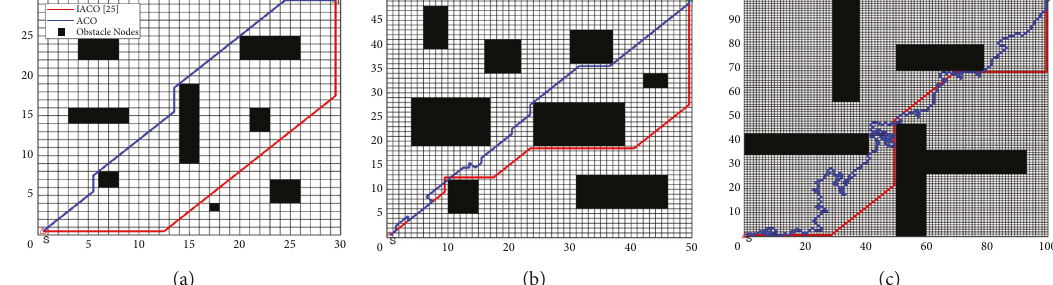
Figure 11: Traditional grid method environment modeling+traditional ACO and improved ACO [26]. (a) 30 ∗ 30. (b) 50 ∗ 50. (c) 100 ∗